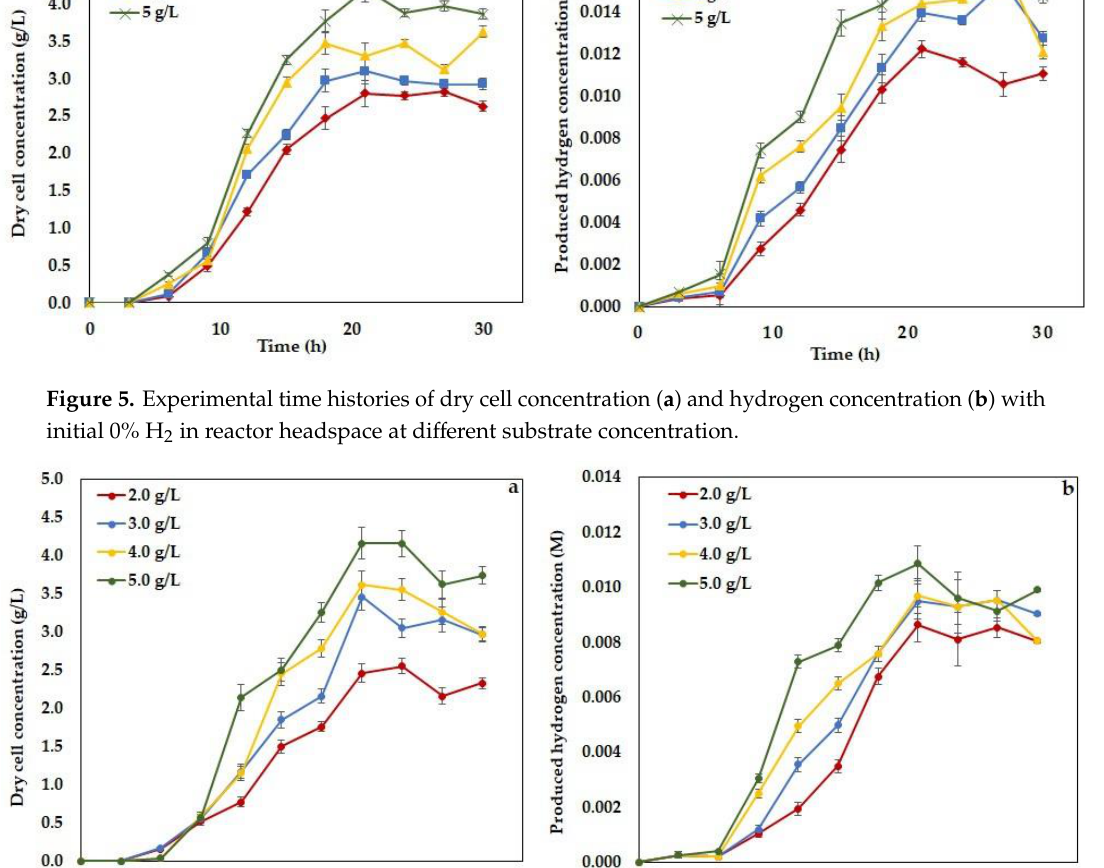
Figure 6. Experimental time histories of dry cell concentration ( a ) and hydrogen concentration ( b ) with initial 10% H 2 in reactor headspace at different substrate concentration.